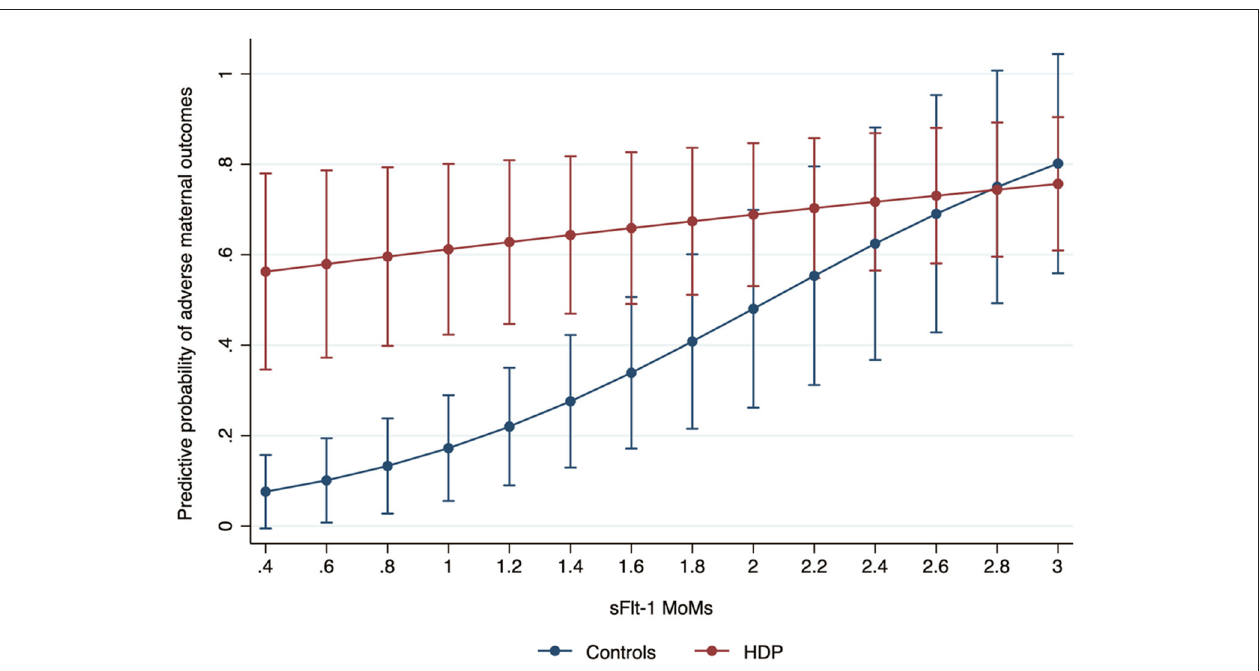
FIGURE 1 | Predictive probability of an adverse maternal outcome among women with hypertensive disease of pregnancy (HDP) according to sFlt-1 MoM